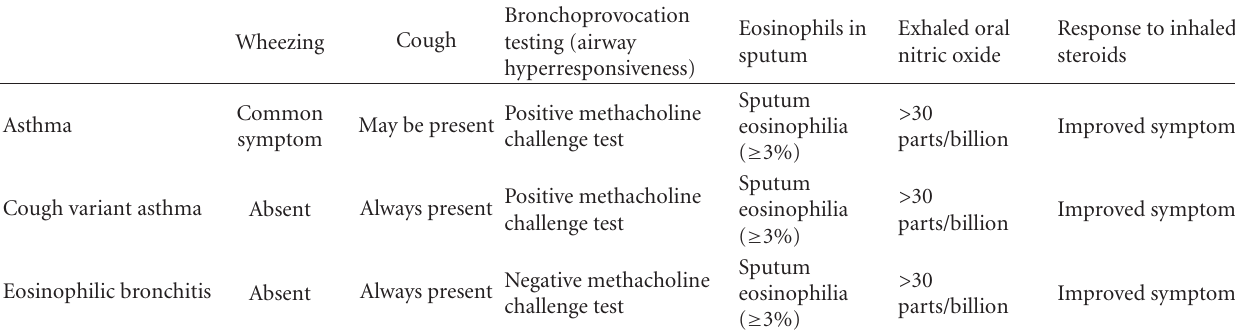
Eosinophils in Exhaled oral Response to inhaled sputum nitric oxide steroids